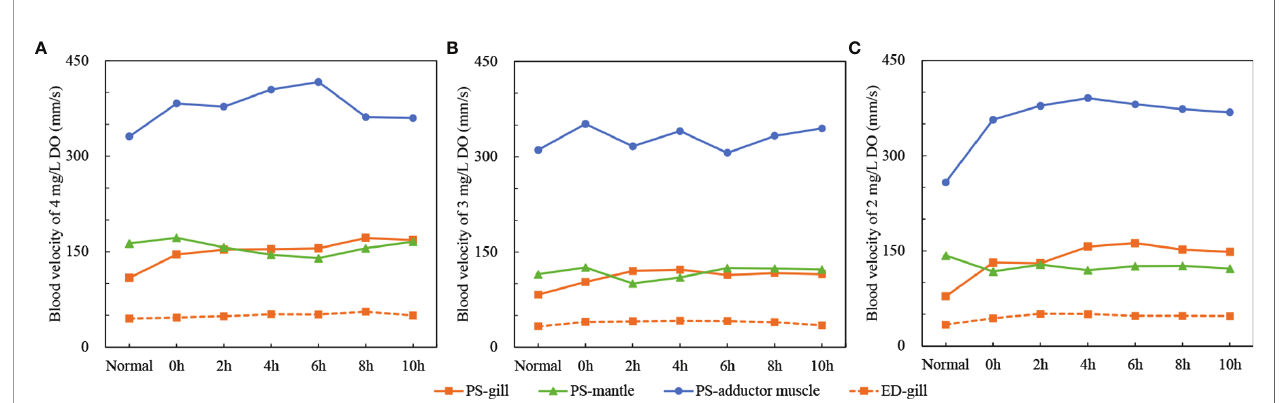
FIGURE 3 | The changes of blood velocity of gill, mantle and adductor muscle under three dissolved oxygen levels [the solid line represents PS, dashed line represents ED, ED only monitored in the gill because the monitored ED values of the mantle and adductor muscle were discontinuous; (A) 4mg/L DO; (B) 3mg/L DO; (C) 2mg/L DO; means ± se, n